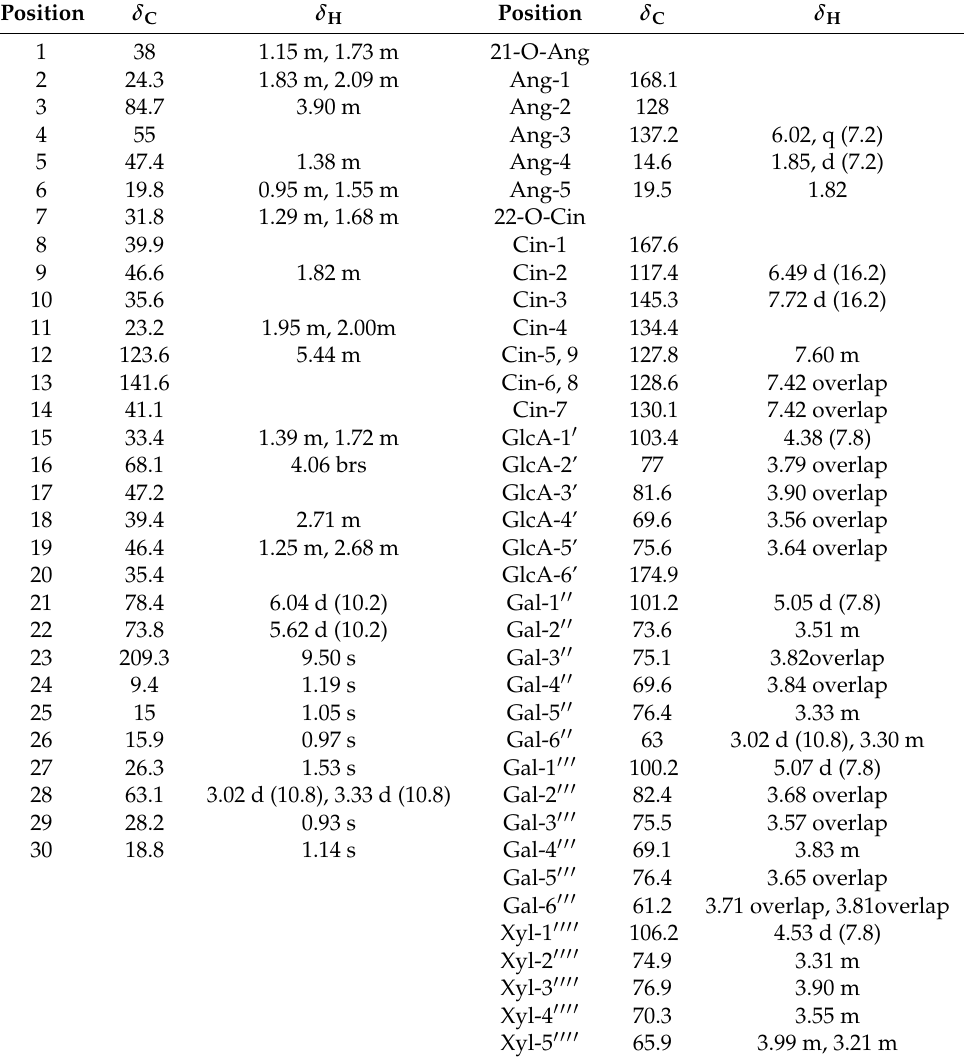
Xyl-5 (cid:48)(cid:48)(cid:48)(cid:48) 65.9 3.99 m, 3.21 m 1 H ( δ ppm, J in Hz, s: Single peak; d: Double peaks; m: Multipeaks) and 13 C-NMR ( δ